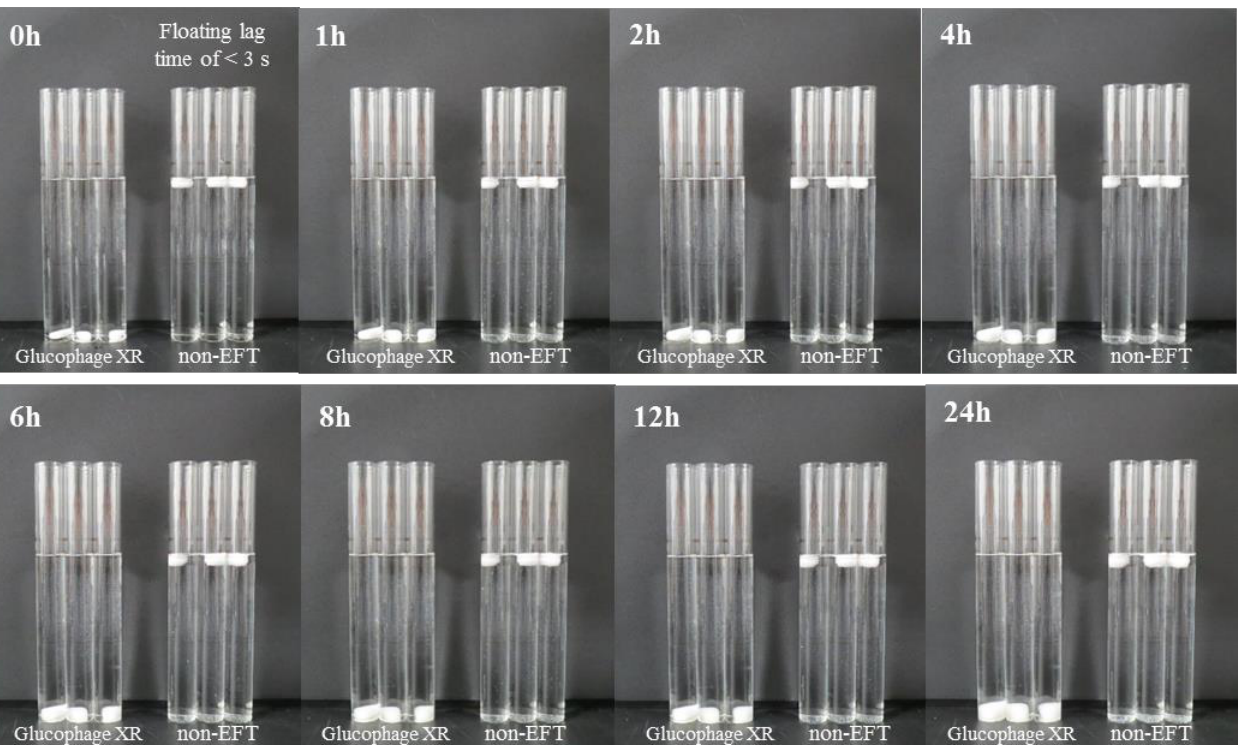
Figure 4. Comparison of the floating ability between Glucophage XR tablets ( n = 3) and non-EFTs ( n = 3).